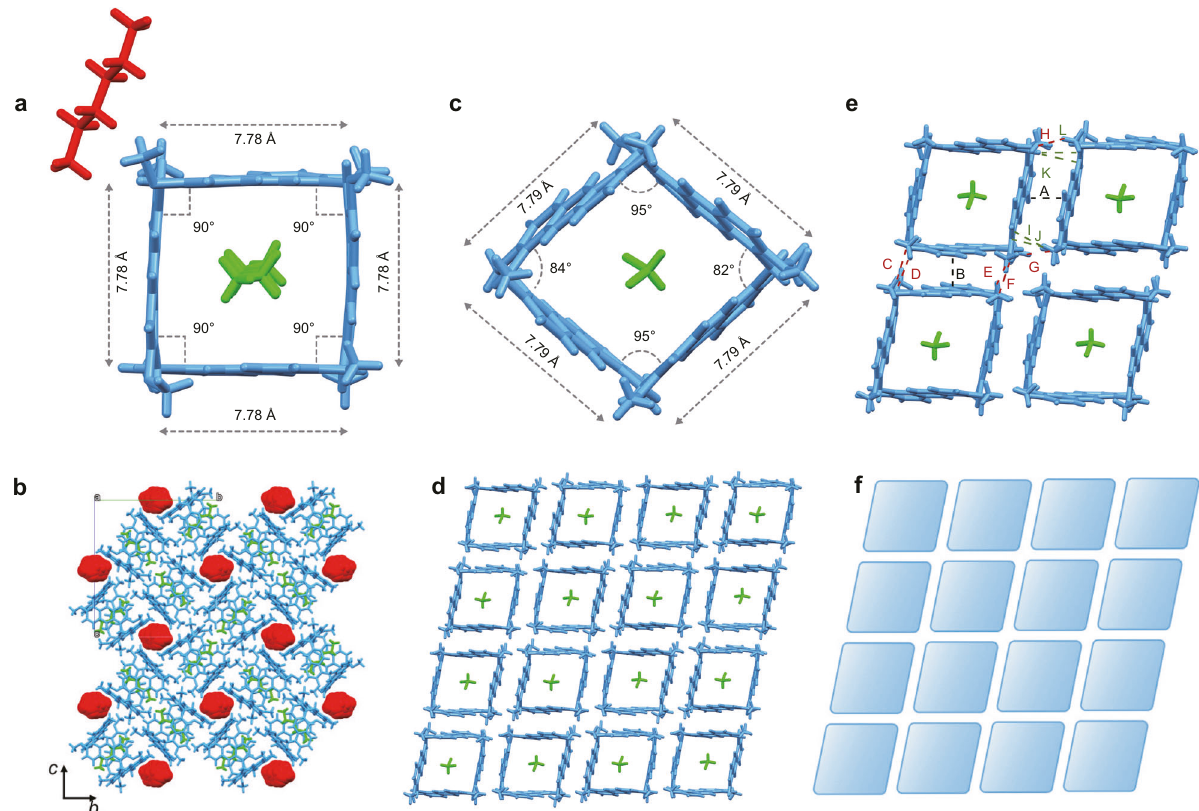
Fig. 4 Supramolecular tessellations of P4 through π ··· π interactions. a Crystal structure of n -hexane@P4 showing the asymmetric unit. b Packing mode of n -hexane@P4 along a axis. c Crystal structure of CH 2 Cl 2 @P4 showing the asymmetric unit. d Two-dimensional regular rhombic tiling in a plane. e Interactions between adjacent P4 in the rhombic basic unit. f Schematic representation of the rhombic tiling. Different colors represent the symmetry